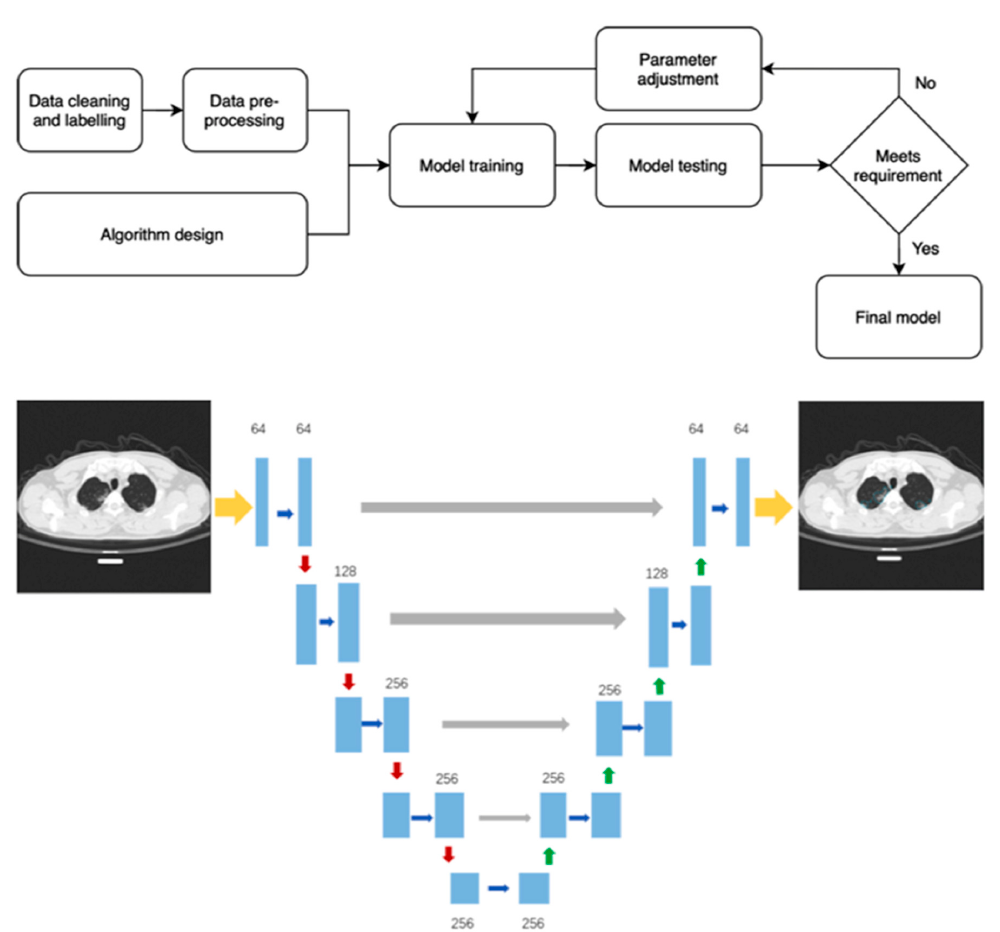
Figure 1. Flowchart of the model training process and a diagram to show how the artificial intelligence (AI) model works to generate a prediction risk of disease.